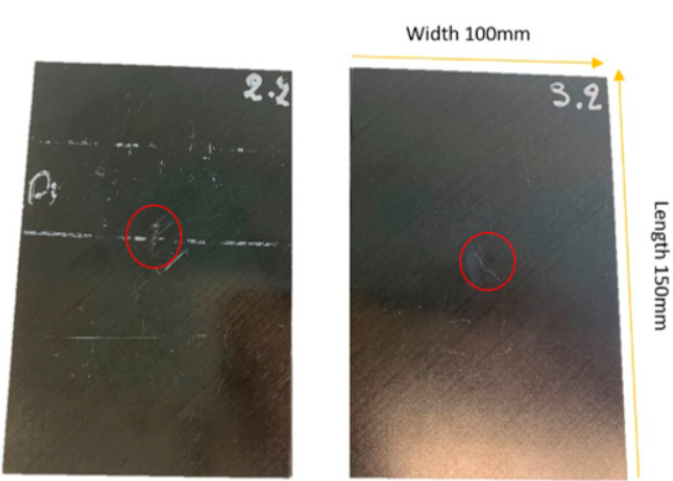
Figure 4. Images of samples 2.2 and 3.2. The samples were manufactured according to the American Society for Testing and Materials (ASTM) standard D7136. The layup is quasi-isotropic (45 / 0 / 45 / 90) with a thickness of 4.2 mm. The red circle highlights the location of the impact from the drop tower. Reflection of the camera taking the image can also be seen.